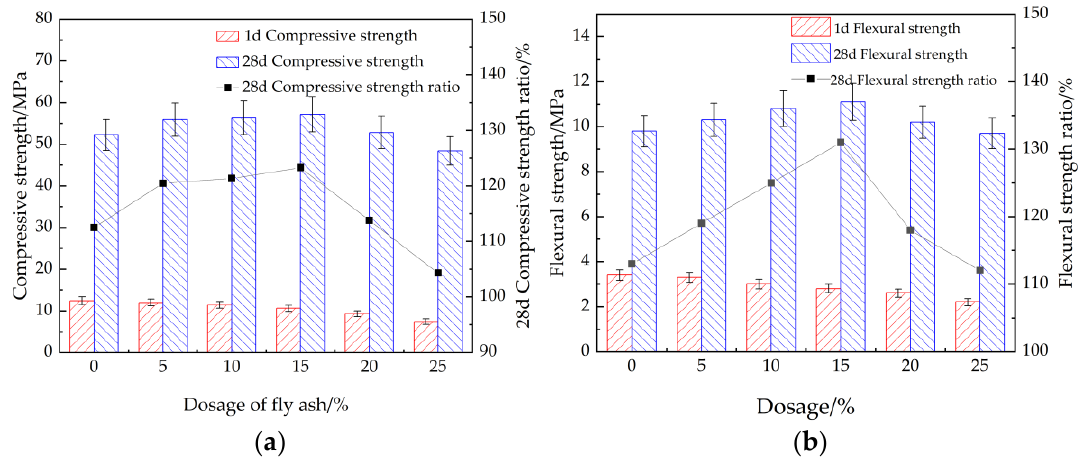
Figure 5. The mechanical strengths of cement mortar with fly ash. ( a ) Compressive strength, ( b ) flexural strength.